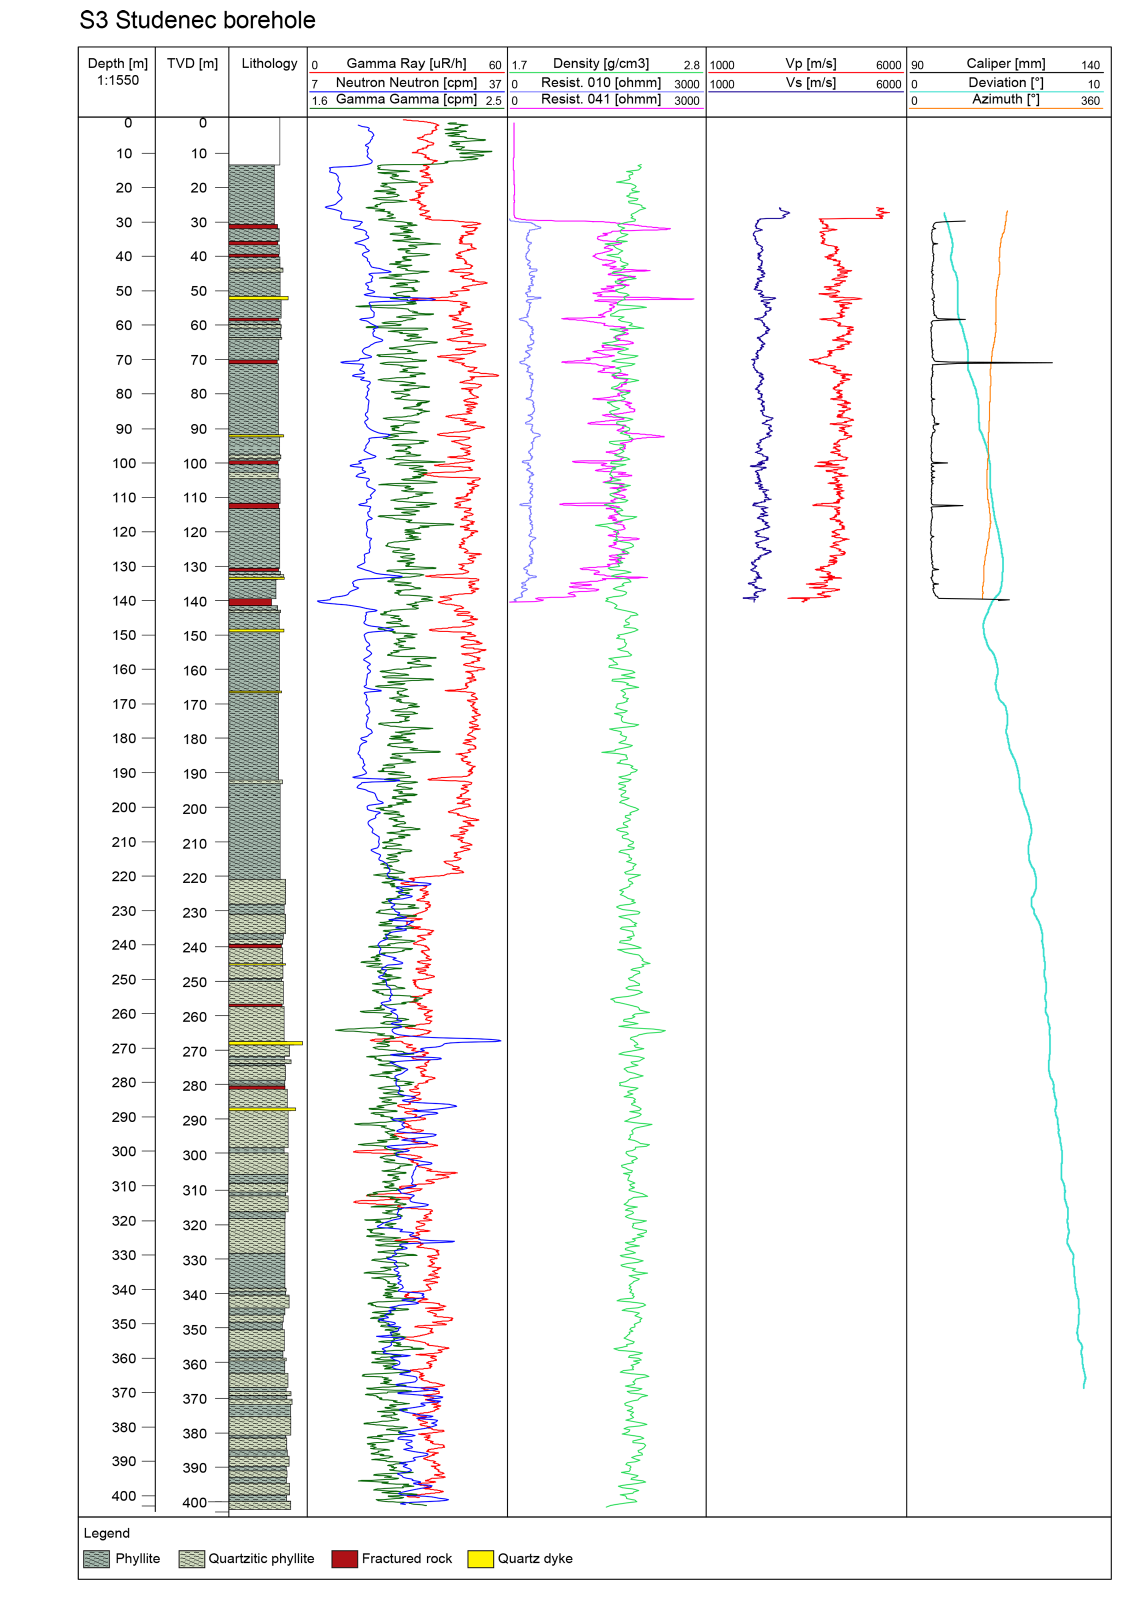
Figure 9. Logging data of the S3 Studenec borehole and a stratigraphy profile based on the initial core description. The abbreviations used in the figure are as follows: TVD – total vertical depth; Resist. – resistivity; V p and V s – P- and S-wave velocity,